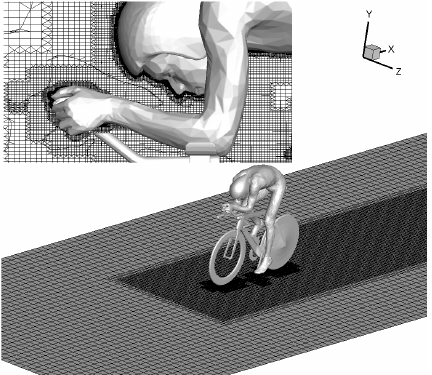
Figure 1. Isometric view of the cyclist model and mesh density on the ground plane. The inset shows a representative example of the mesh details in the immediate vicinity of the rider’s arms and